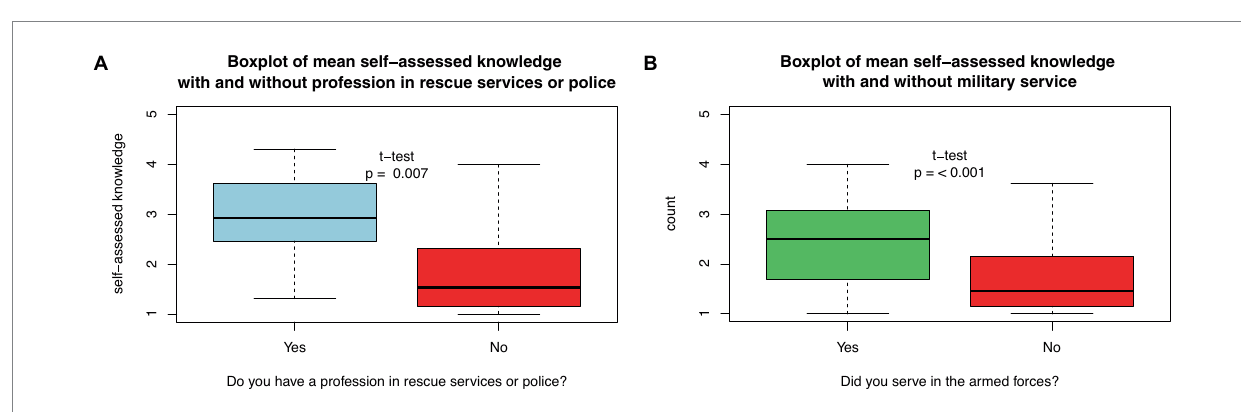
FIGURE 7 Differences in mean self-assessed disaster medical knowledge between (A) those who had served in rescue/police services or not and (B) those who had served in the armed forces or